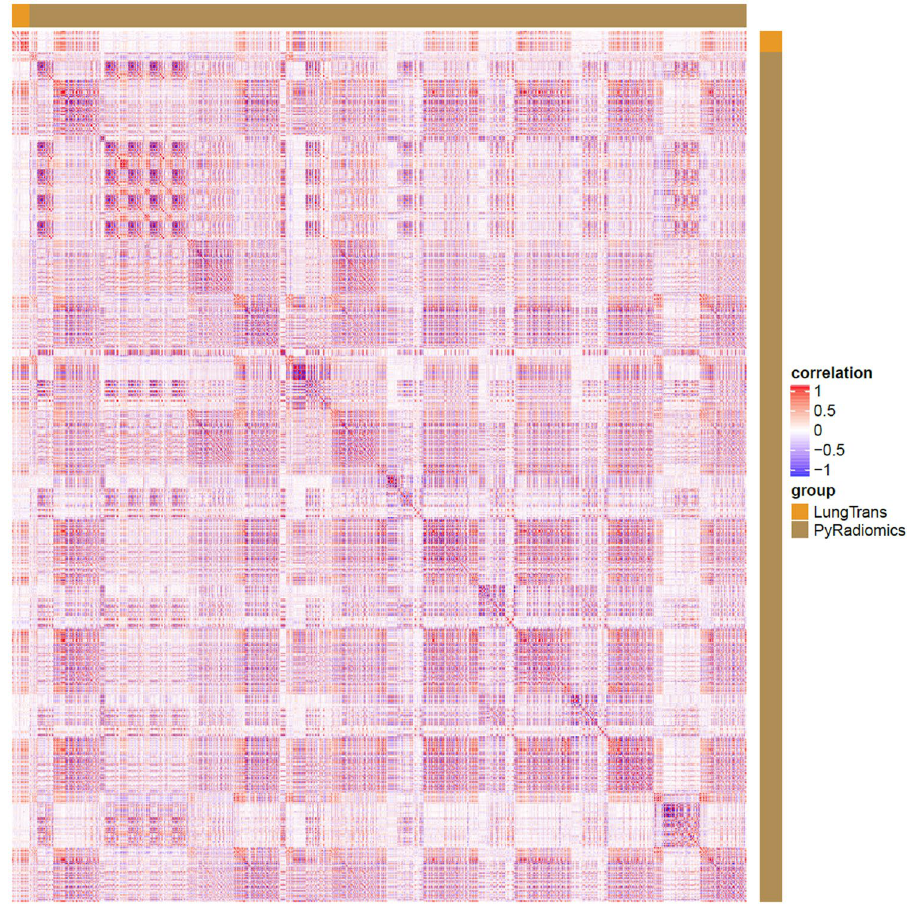
Figure 3. Correlation heatmap of PyRadiomics and LungTrans